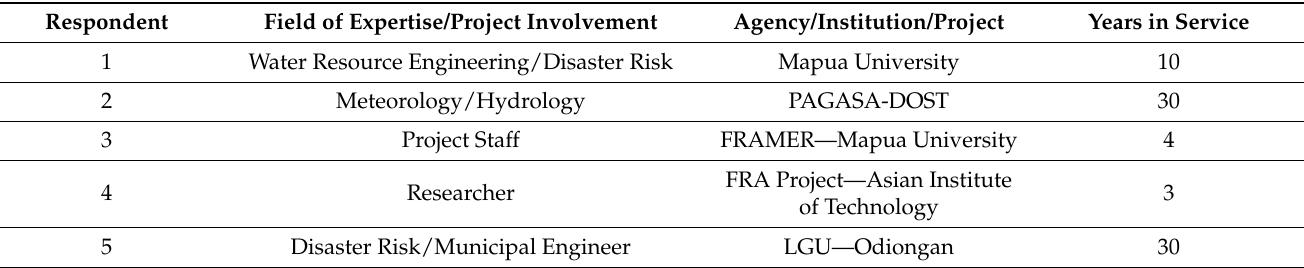
Table A3. Respondent’s credentials for pairwise comparison